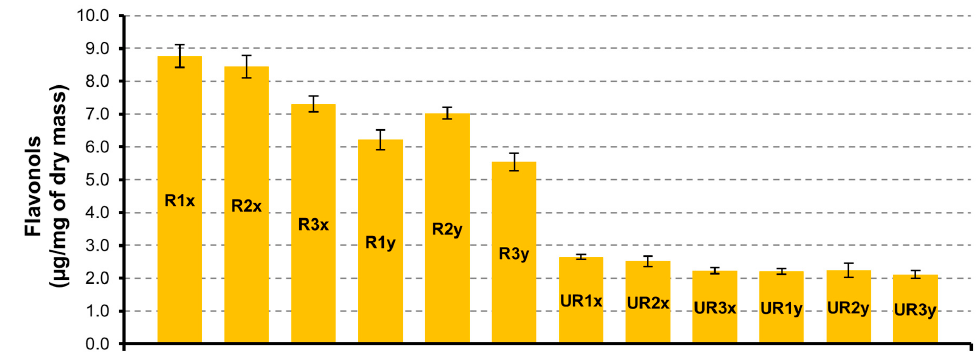
Figure 1. Flavonols quantification in CAR-R and CAR-UR extracts; 1 (24 h), 2 (48 h), and 3 (72 h) time of drying; x (3 h) and y (6 h) time of extraction.